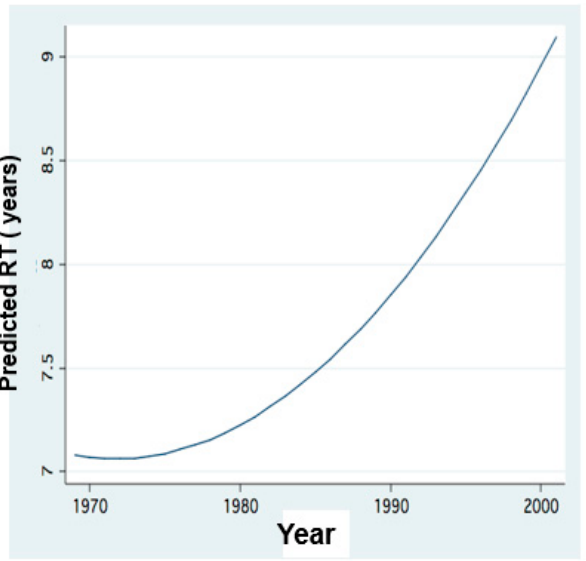
Figure 12. Temporal changes of Residence Time length in Lake Kinneret: FP regression between Annual means of monthly Residence Time (RT) value (years) and years in Lake Kinneret (1970–2018). The relations between discharges of River Jordan and DIN (Dissolved Inorganic Nitro-